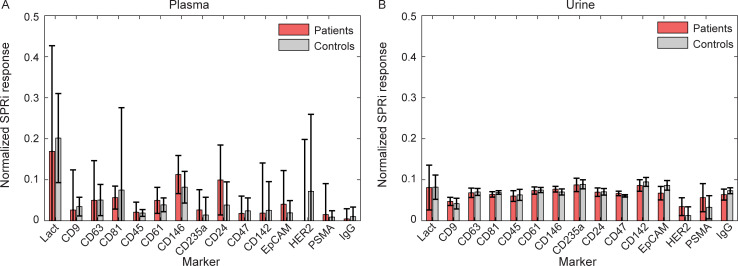
Surface plasmon resonance imaging (SPRi) response for plasma (A) or urine (B) of metastatic castration-resistant prostate cancer patients (red, n = 5), healthy controls (grey, n = 5) and phosphate buffered saline (blue, n = 2) for different markers. Data shown represent the median and standard deviation (whiskers) per group. Lact: lactadherin; RU: resonance unit.